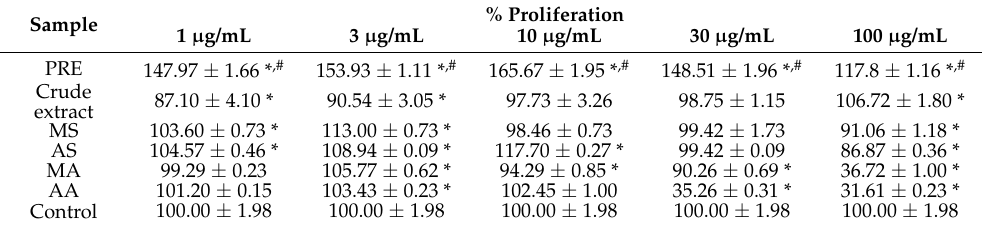
Table 2. Effect of PRE, crude extract, and pure isolated compounds (MS, AS, MA, and AA) on HDF cell proliferation.